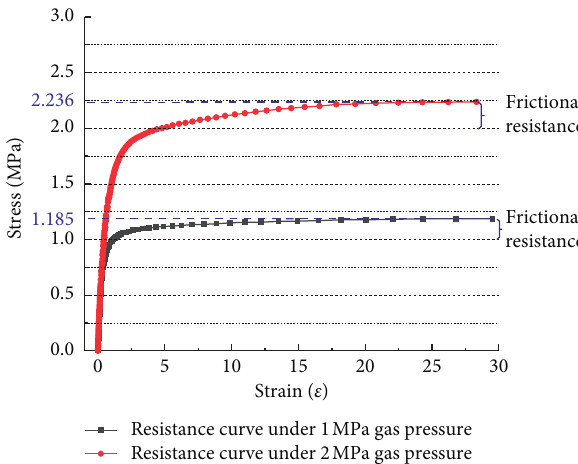
Figure 4: Testing curves of resistance.